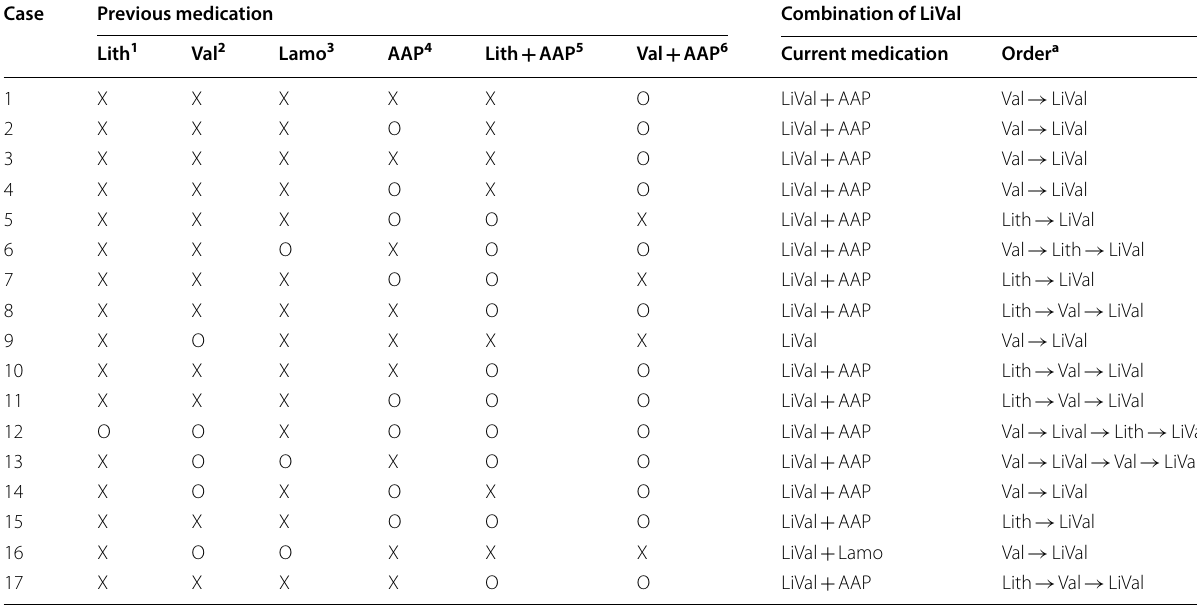
Lith, lithium; Val, valproate; AAP, any atypical antipsychotic medication; LiVal, lithium and valproate combination; Lamo, lamotrigine a The order in which lithium and valproate were administered